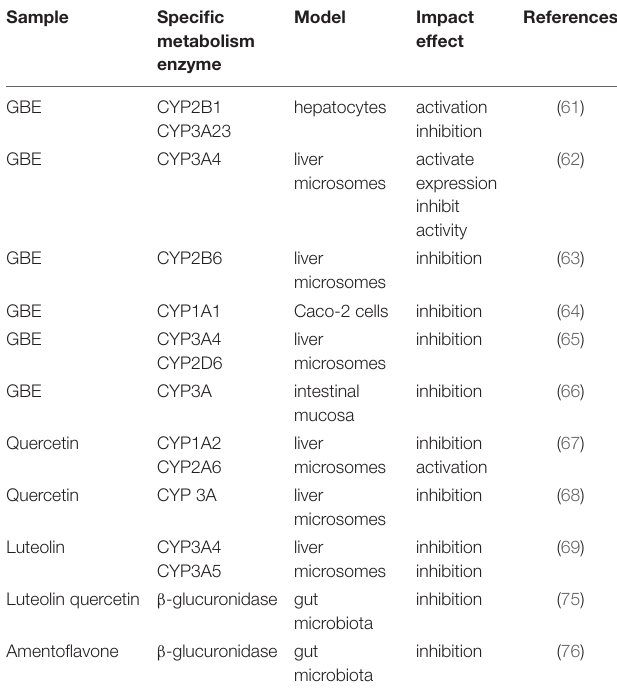
TABLE 1 | Impact of flavonoids of Ginkgo biloba on metabolism